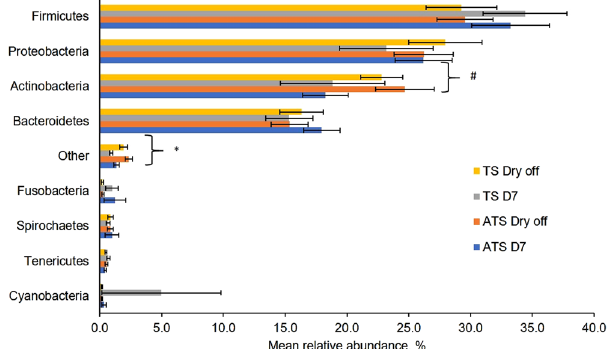
Figure 4. Bar graph illustrating the mean relative abundance of major phylum types either on cows receiving dry cow therapy with antibiotic (ceftiofur hydrochloride) and teat sealant (ATS) or dry cow therapy only with teat sealant (TS) at Dry off and 7 days postpartum. Error bars correspond to standard error of the mean. * P < 0.05 for time effect. # P < 0.10 and P > 0.05 for time